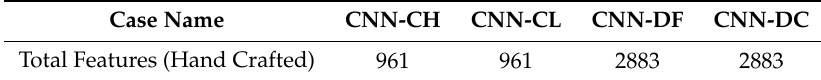
Table 1 summarises extracted local features for different cases: Table 1. Number of handcrafted